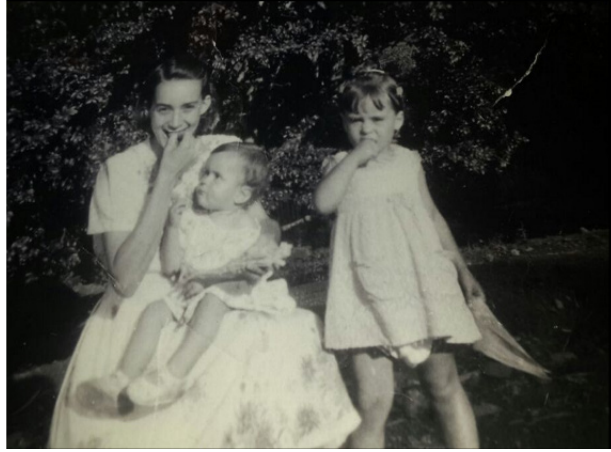
Fig. 2 - Tomas, his mother Silvéria, and his sister